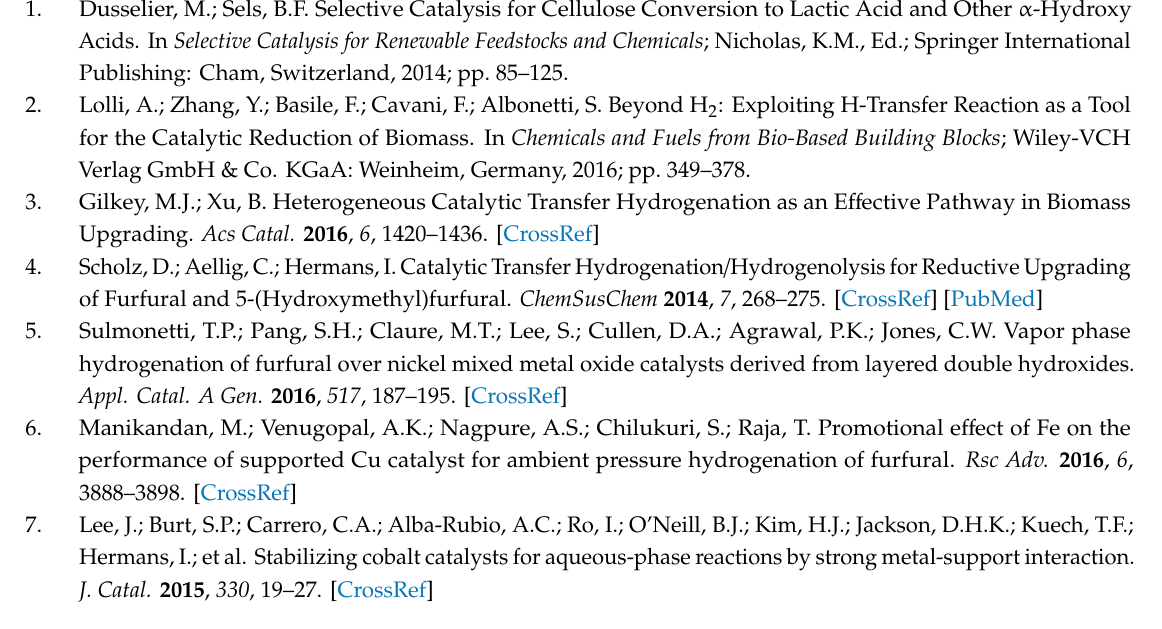
Figure S1: Pyridine-FTIR spectra of Fe / Mg / O_1_1 obtained after evacuation at di ff erent temperatures: (a) room temperature; (b) 100 ◦ C; (c) 200 ◦ C; (d) 300 ◦ C; and (e) 400 ◦ C. Figure S2: Pyridine-FTIR spectra of Fe / Mg / O_1_2 obtained after evacuation at di ff erent temperatures: (a) room temperature; (b) 100 ◦ C; (c) 200 ◦ C; (d) 300 ◦ C; and (e) 400 ◦ C. Figure S3: Pyridine-FTIR spectra of FeO x / MgO_1_10 obtained after evacuation at di ff erent temperatures: (a) room temperature; (b) 100 ◦ C; (c) 200 ◦ C; (d) 300 ◦ C; and (e) 400 ◦ C. Figure S4: Pyridine-FTIR spectra of FeO x / MgO_1_2 obtained after evacuation at di ff erent temperatures: (a) room temperature; (b) 100 ◦ C; (c) 200 ◦ C; (d) 300 ◦ C; and (e) 400 ◦ C. Figure S5: Furfural adsorption and desorption over MgO sample from RT to 400 ◦ C. Figure S6: Furfural adsorption / desorption over FeO / MgO_1_10 sample from RT to 400 ◦ C. Figure S7: FTIR x spectra of Furfuryl alcohol adsorption / desorption over MgO at di ff erent temperature. Figure S8: Furfuryl alcohol adsorption / desorption over FeO x / MgO_1_10 within di ff erent